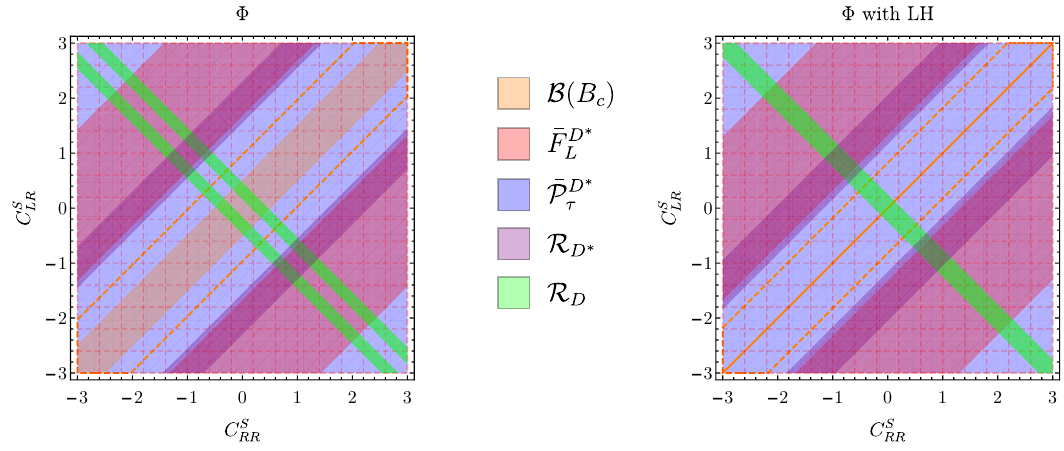
Figure 4 . Fit-independent plot of Scenario 4 , displaying the regions allowed at 1 (cid:27) . On the left panel only the RHN Wilson coe(cid:14)cients shown are switched on ( Scenario 4a) , whereas on the right panel we set the left-handed neutrino Wilson coe(cid:14)cients entering in Scenario 4b to their best-(cid:12)t values. The dashed orange line shows the more relaxed bound B ( B c ! (cid:28) (cid:22) (cid:23) ) (cid:20) 30%, and the red grid shows the parameter space consistent with the experimental measurement of (cid:22) F D (cid:3)